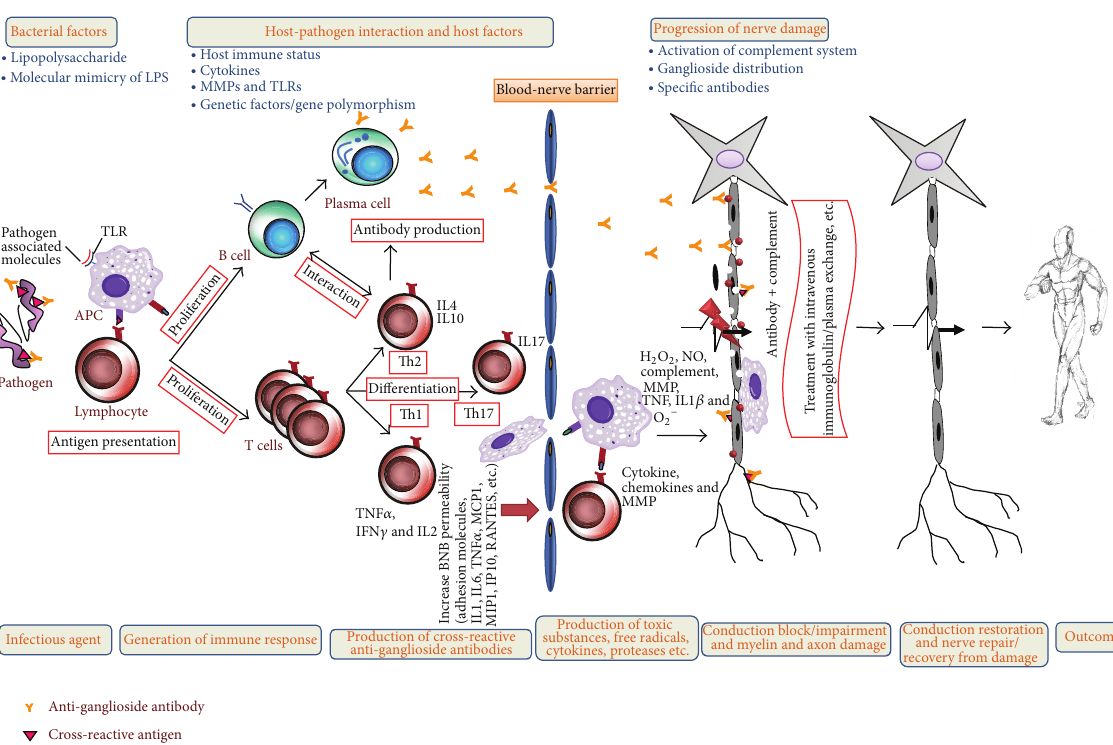
Figure1:OverviewofimmunopathogenesisofGBS.Abacterialcross-reactiveantigenrecognizedbymacrophagesandTcellsthathelpBcells toproduceanti-gangliosideantibodieswhichpenetratesblood-nervebarrierandcanactivatecomplement.Theseantibodiesbindwithspecific nervegangliosidesandantigenaswell.Activatedendoneurialmacrophagesreleasecytokines,proteases,andfreeradicals(nitricoxide,oxygen, and hydrogen peroxide), invade compact myelin and periaxonal space, and sometimes block nerve conduction or cause axonal degeneration. Activated T cell releases proinflammatory cytokines, fixes complement, damages Schwann cell, and ultimately produces dissolution of myelin.